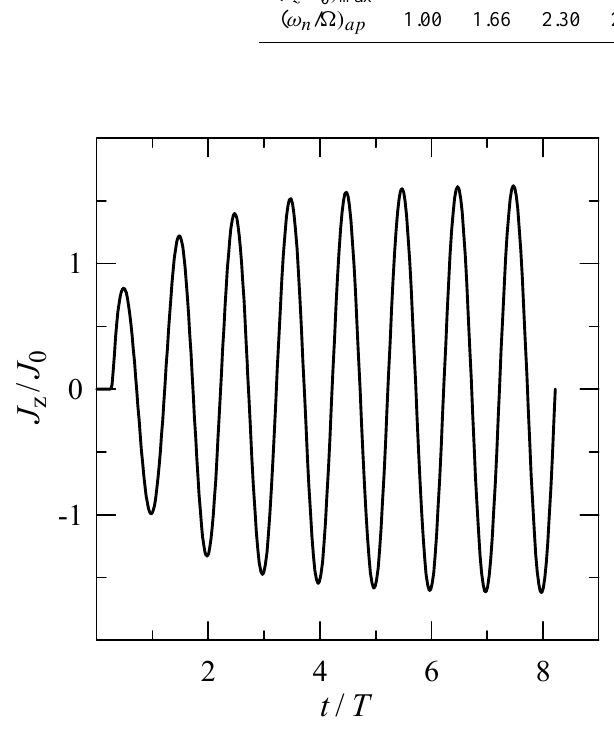
Fig. 4. Dependence of J z / J 0 on time t at the fixed height 400 km for the periodic source with the frequency ω = (cid:127) =2 π / T , where T is the IAR fundamental